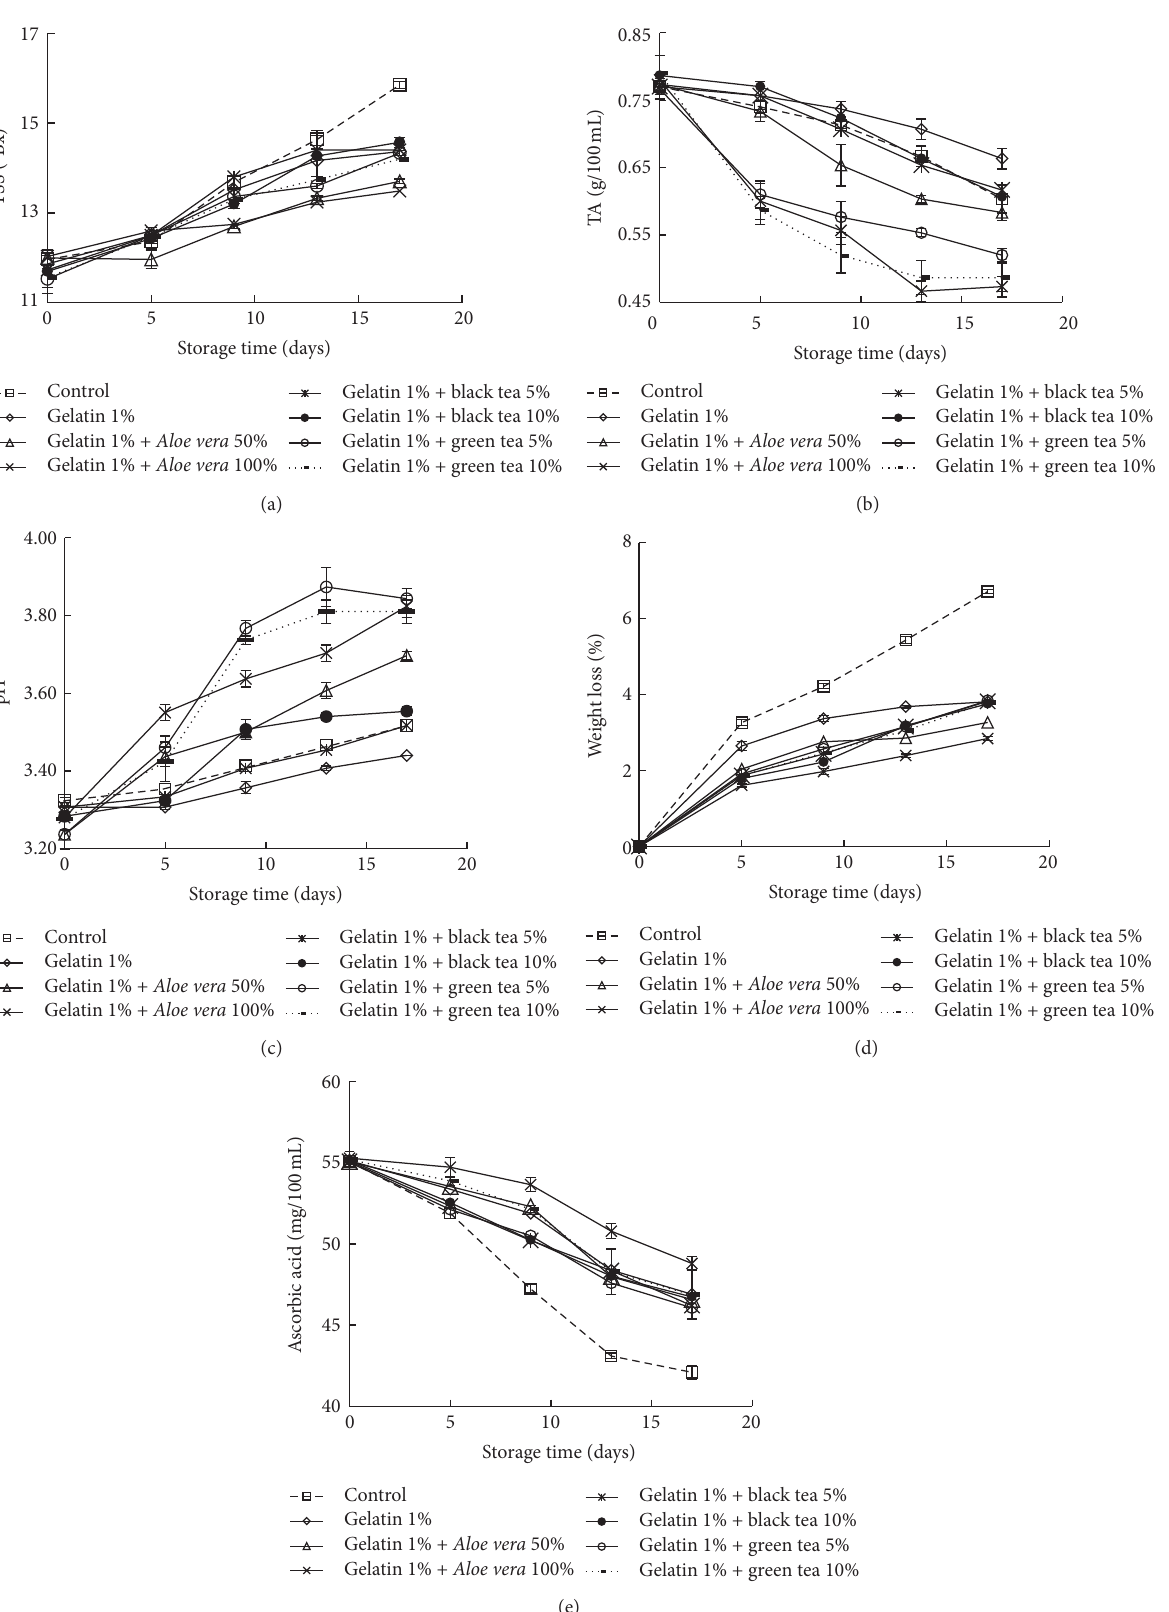
Figure 1: The variation of pH, total soluble solid (TSS), titratable acidity (TA), weight loss, and ascorbic acid content of coated fresh-cut oranges during storage at 4 ∘ C for 17 days. Error bars represent standard deviation between replicates ( 𝑛 = 3